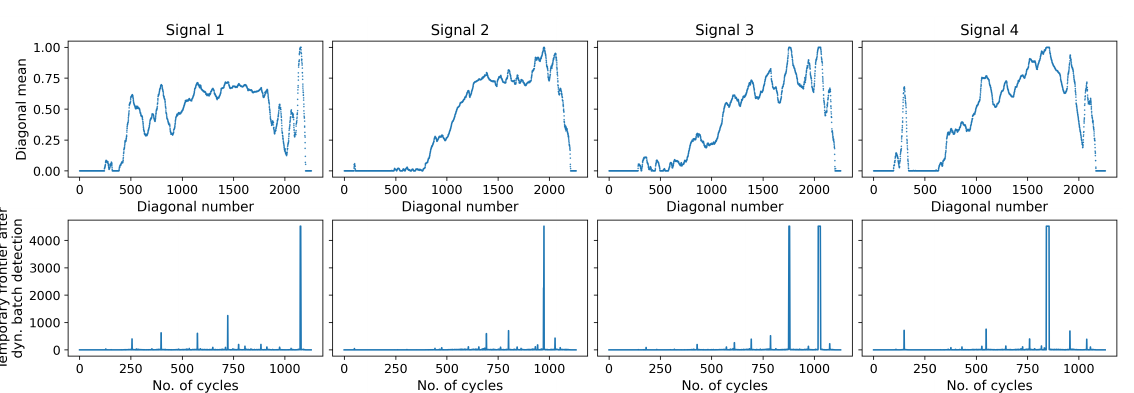
Figure 10. Frontier extraction ( second row ) from signal computed in Section 3.4 ( first row ) on each